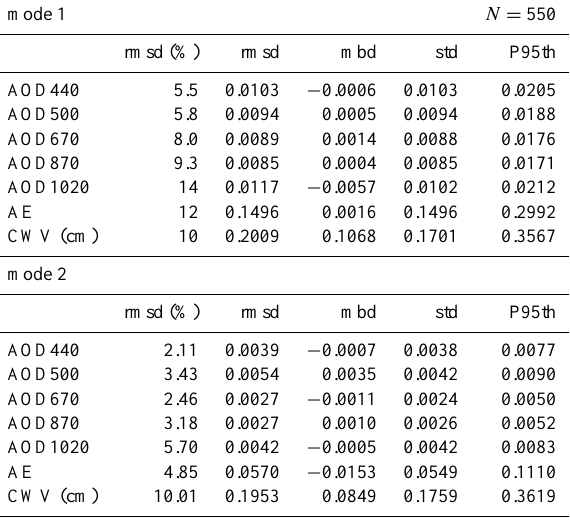
Table 5. Statistics summary (root mean square deviation – absolute and expressed as percentage (%), mean bias deviation, standard de- viation of differences, and 95th percentile) between PREDE direct sun products obtained by ESR and the CIMEL direct sun producs obtained by AERONET for mode 1 (top) and mode 2 (bottom). The number of data samples ( N ) is also